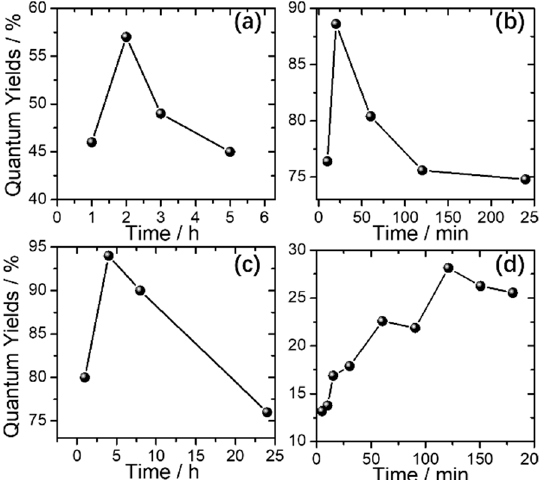
Figure 6. Reaction time vs. quantum yields of CDs synthesized from CA by ( a , c ) hydrothermal method and ( b , d ) thermal decomposition. The data in ( a – d ) are organized according to results in Ref. [57], Ref. [25], Ref. [30], and Ref. [58], respectively.